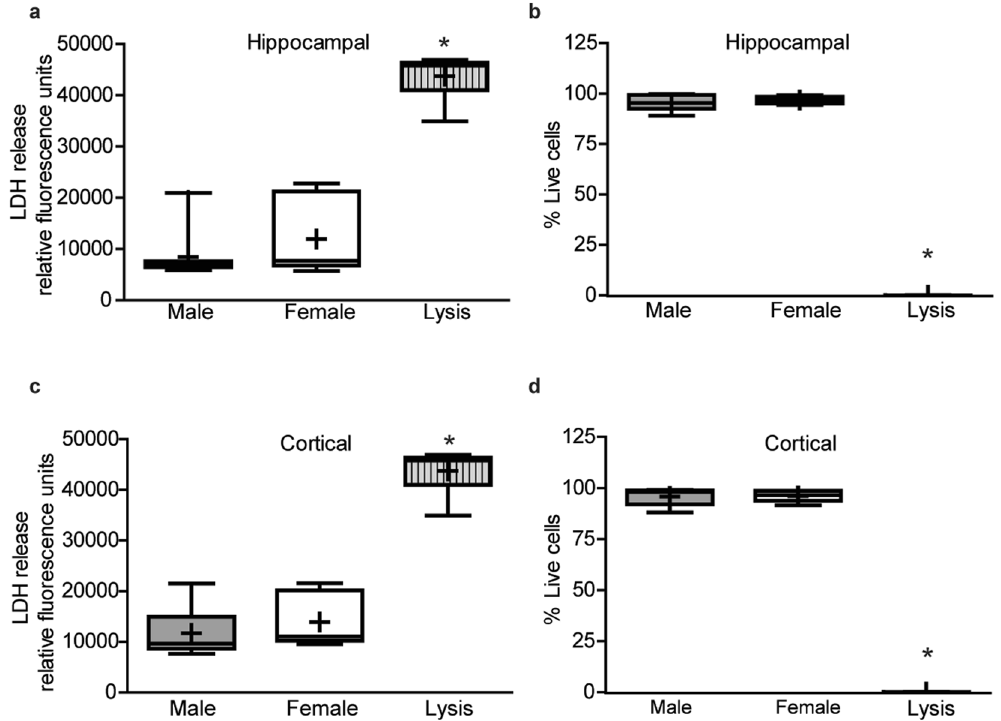
Figure 6. Cell viability does not differ by sex in hippocampal and cortical cultures. Sex-specific neuron-glia co-cultures were established from P0 mouse hippocampi ( a , b ) or neocortices ( c , d ). On DIV 9, cell viability was analyzed by measuring lactate dehydrogenase (LDH) release into the medium ( a , c ) or by quantifying the percentage of live cells in cultures stained with calcein AM (biomarker of live cells) and propidium iodide (biomarker of dead cells) using Metamorph image analysis software ( b,d ). As a positive control, a subset of cultures for each experimental condition were lysed with 0.2% Tritox X (Lysis). In box plots, “ + ” indicates the mean; whiskers, the 10–90 th percentile (n = 6–9 wells per sex from at least three independent dissections). Live dead cell analysis was conducted on imaged sites (9 fields/well) which contained greater than 250 total cells counted per field. Significant differences were determined using one-way analysis of variance (ANOVA) followed by Tukey’s post hoc analysis for parametric data ( b ) or Kruskal Wallis test followed by Dunn’s post hoc analysis for nonparametric data ( a , c , d ). Asterisk indicates a significant difference between groups at p ≤ 0.05.